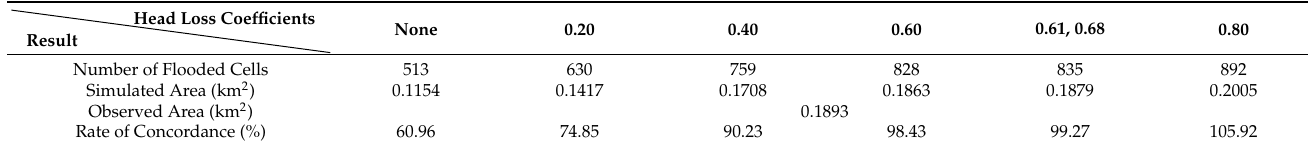
Table 8. Change of the inundation area by the application of head loss coefficients (Gildong).